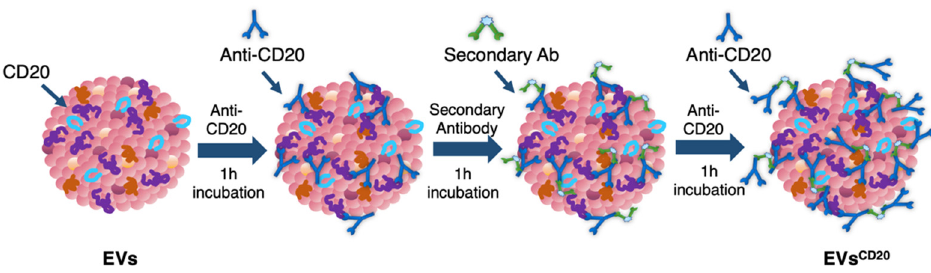
Figure 1. Schematic representation of the three steps for EV surface functionalization with the targeting antibody targeting antibody anti-CD20.